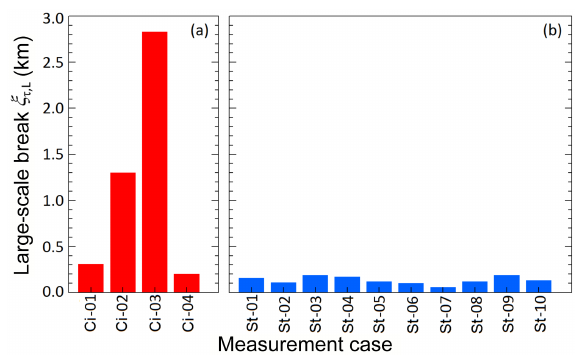
Figure 7. Across swath-derived large-scale breaks, ξ τ, L for the re- trieved fields of τ from the (a) CARRIBA (Ci-01 to Ci-04, red) and (b) VERDI (St-01 to St-10, blue) campaigns. The values were de- rived using the method presented in Fig.